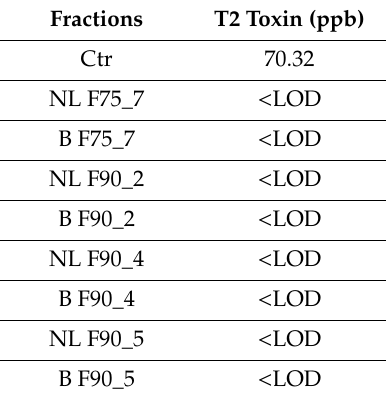
Figure 6. Biological assay of the F. langsethiae growth in samples non treated (ctr) and treated with the fractions indicated in the graph legend after 1, 2, 3, 4, 5, 6, 7 dai. The results are the mean ± SD of 3 different experiments. Table 3. T2 production by F. langsethiae treated and non-treated (ctr) with the different fractions after 7 dai at 25 °C.